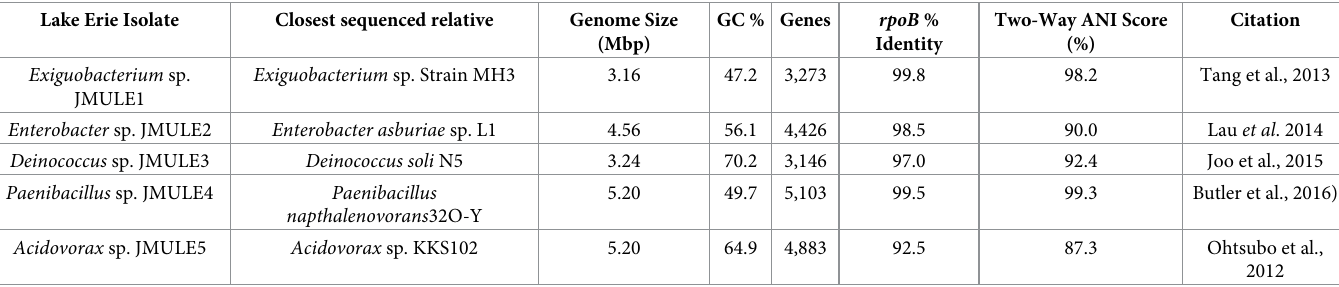
Table 2. Closest sequenced relatives of each isolate based on rpoB identity and ANI score. Lake Erie Isolate Closest sequenced relative Genome Size